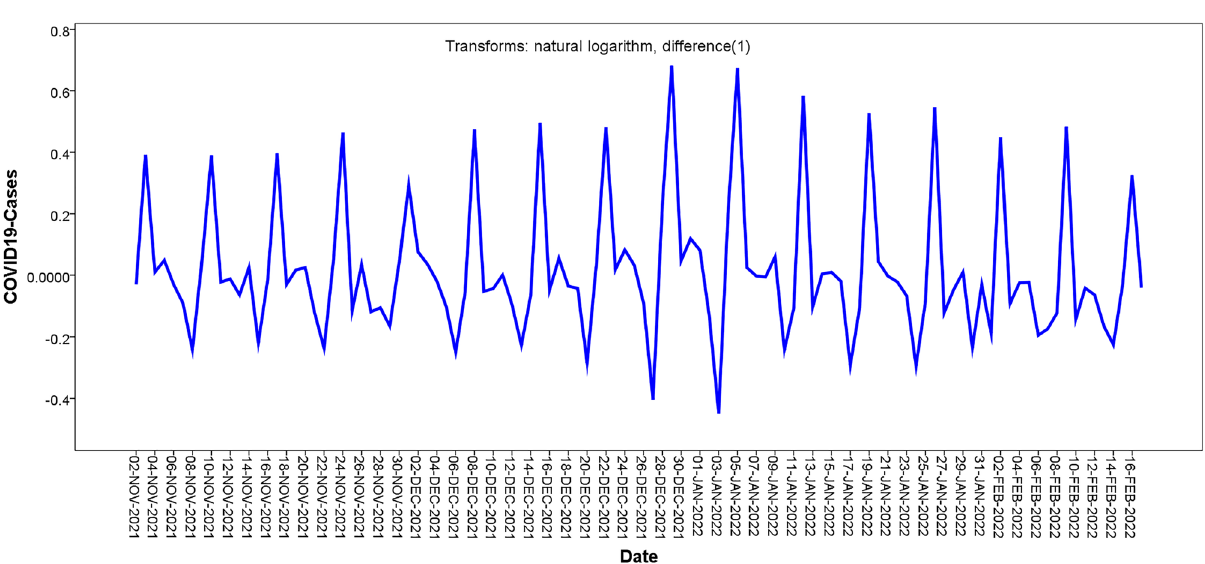
Figure.3. Time series chart of after the first-order difference and natural logarithm